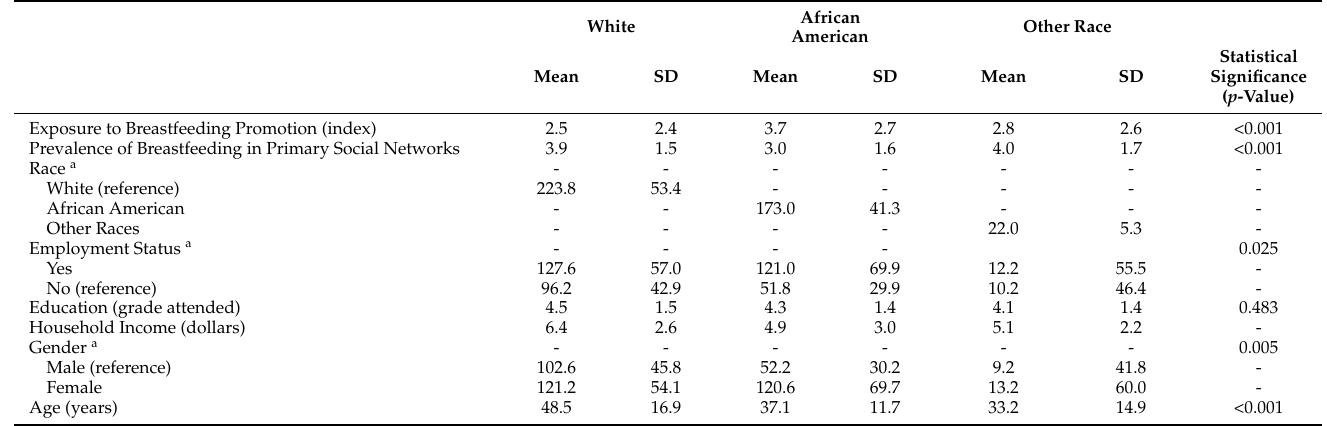
Table 1. Sample characteristics by race ( n = 419).